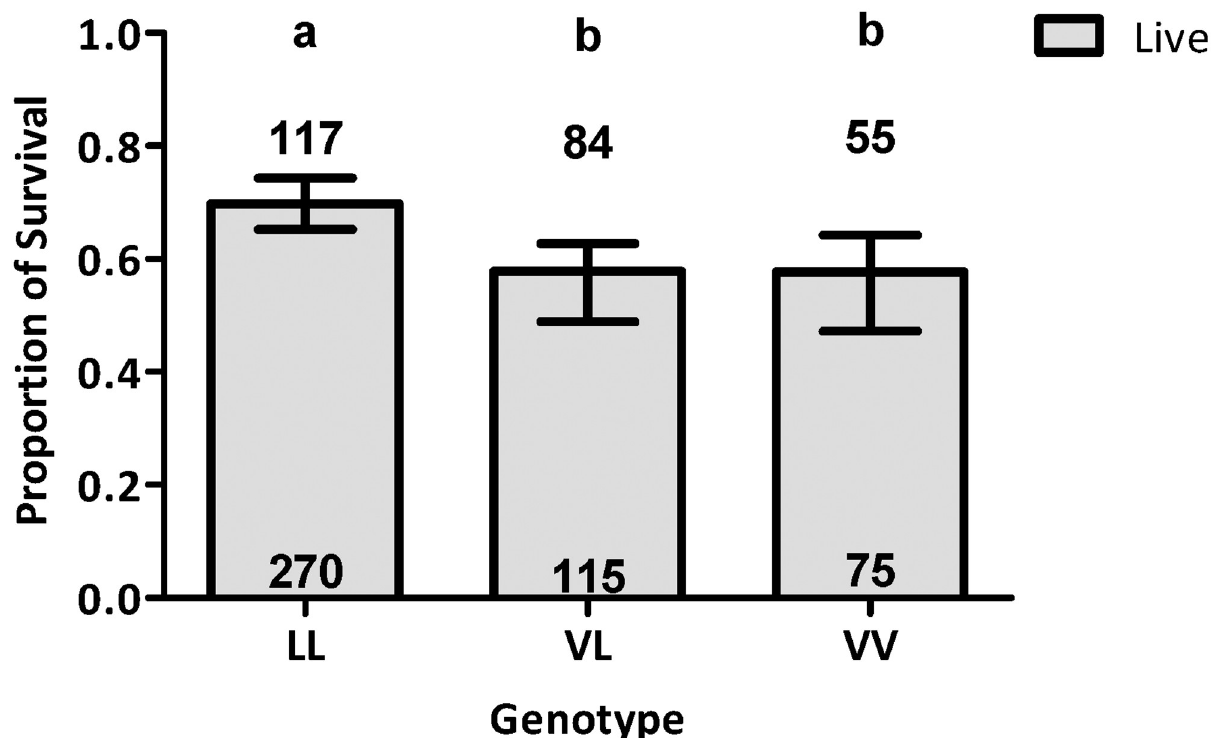
Fig 3. Impact of genotype at the 410 site on female survival after Permanone 31–66 tests. Estimated proportion of surviving females of Ae . aegypti by genotypes at the 410 site. There were highly significant differences in the proportion of surviving females among VV, VL and LL genotypes ( P = 0.0037). The histogram shows the estimated proportions of surviving females ± CI, and different letters (a-b) above bars indicate differences in the proportions of surviving females (Fisher’s Exact Test). Numbers in the grey bars of the histogram are the surviving females, and the numbers above the histogram represent the number of dead